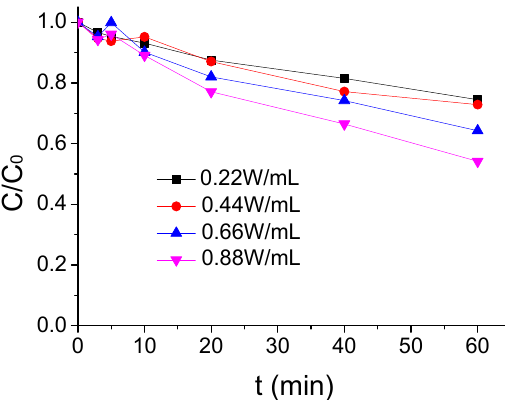
Figure 4. The ATZ removal rate under a different US intensity ( C 0 = 1.25 μ mol/L).